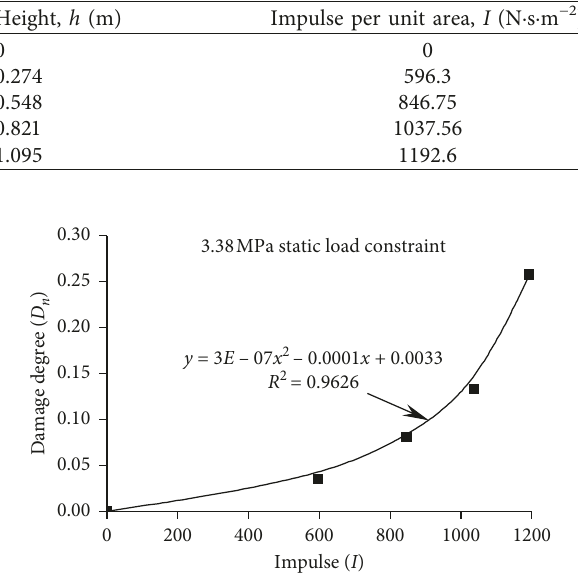
Figure 6: The relationship between damage degree and in- cremental impulse.